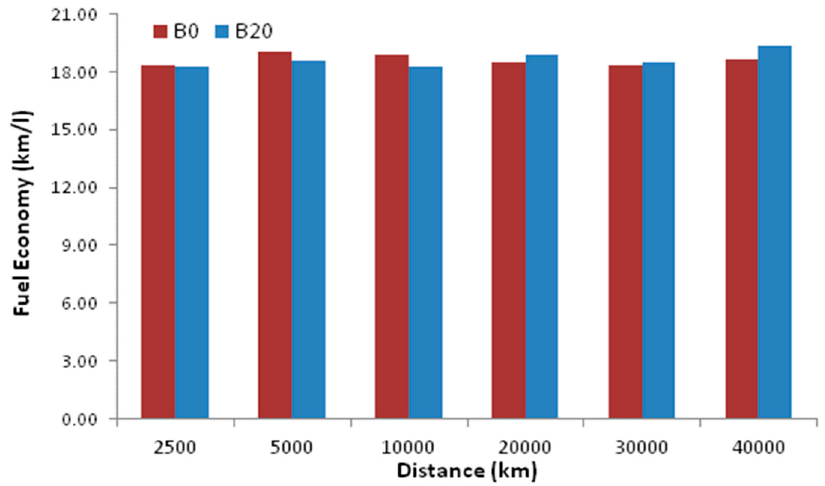
Figure 5. Fuel economy for B0 and B20 at each distance traveled.